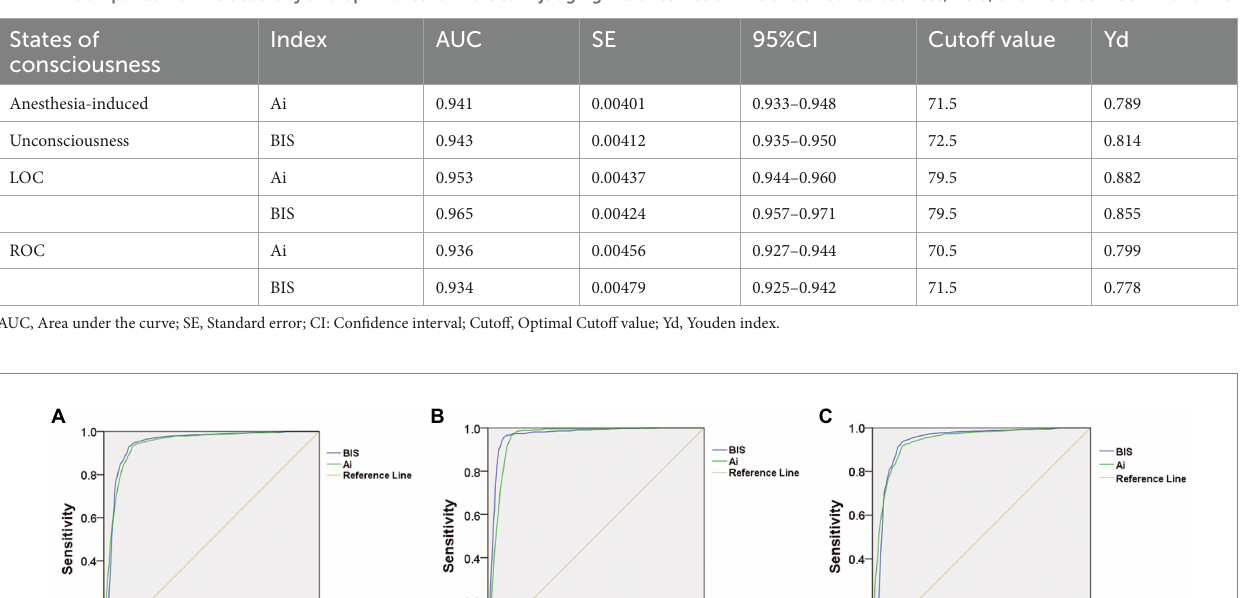
TABLE 2 Comparison of the accuracy and optimal cutoff values in judging the anesthesia-induced unconsciousness, LOC, and ROC between Ai and BIS.